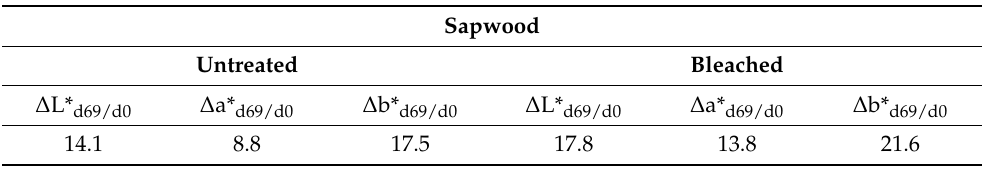
Table 6. Evolution of ∆ L*, ∆ a*, and ∆ b* values of untreated and bleached sapwood between the first (d0) and the last (d69) irradiation day.